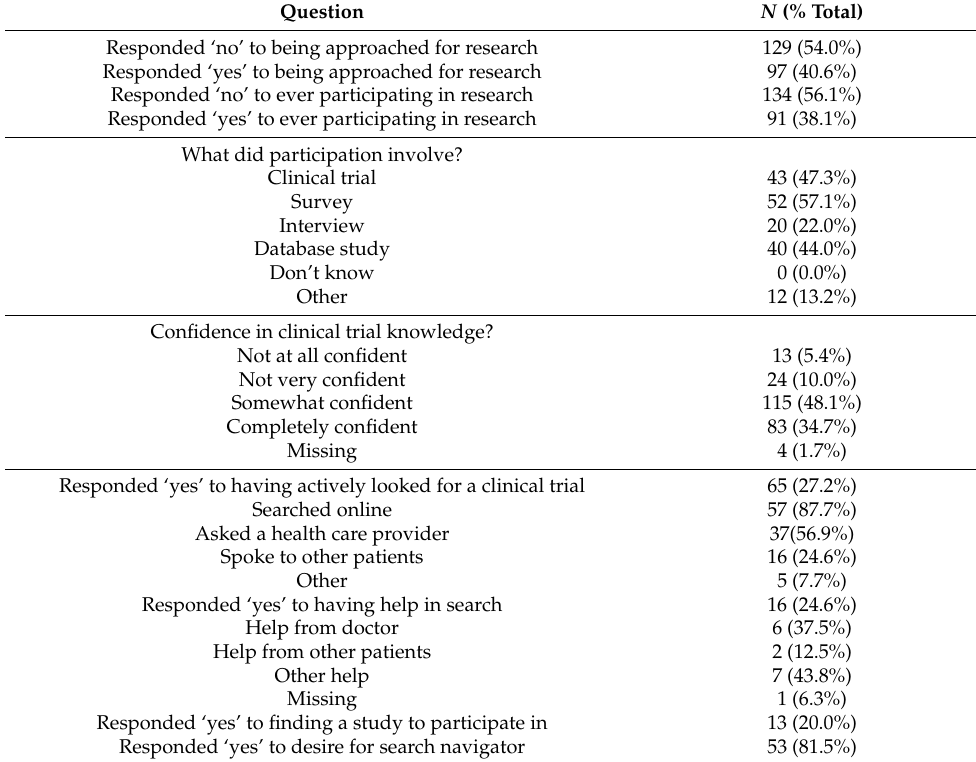
Table 2. Reported experience with and knowledge about clinical trials ( N =